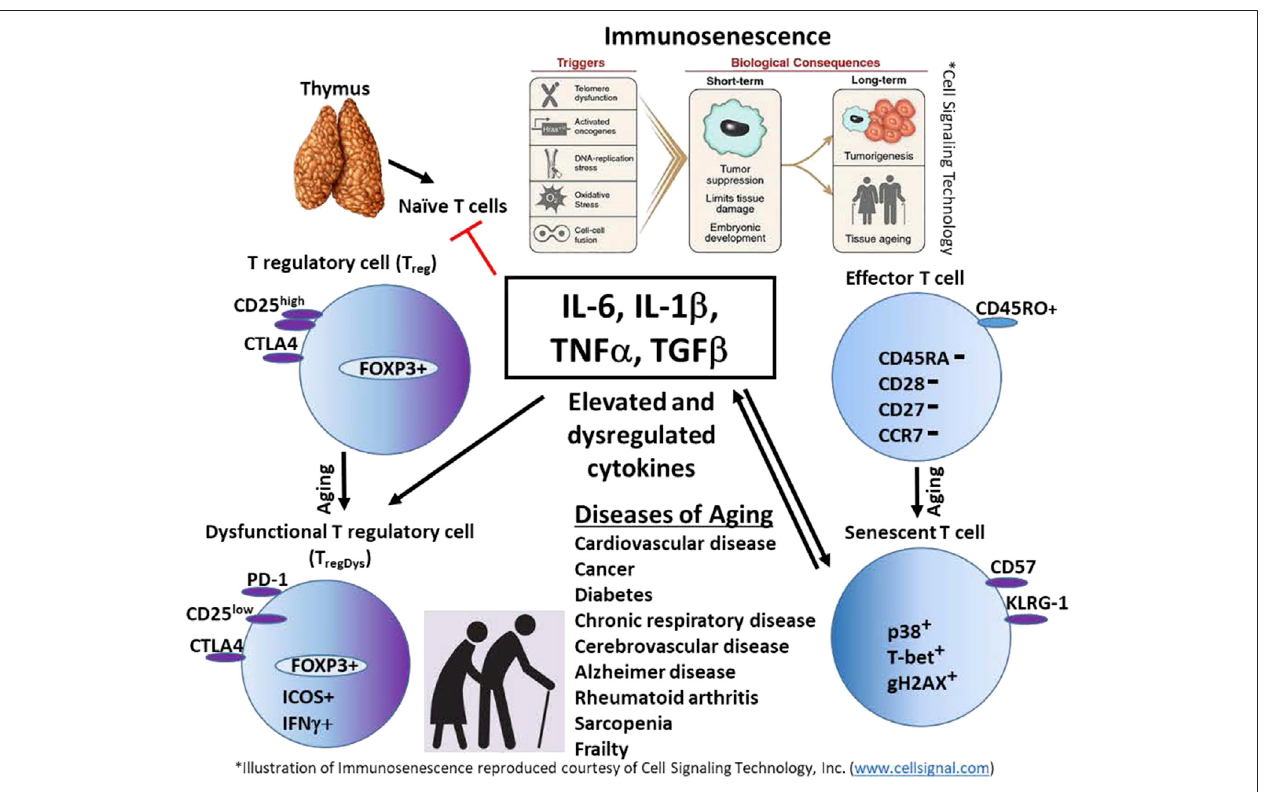
FIGURE1| Model. Persistentelevation ofinnatecytokines such asIL-6, IL-1 β ,TNF α ,and TGF- β ,contribute toimmunosenescence intheelderly. Thesecytokines also promote T cell senescence. Senescent T cells perpetuate in fl ammation by secreting in fl ammatory cytokines. IL-6 also may promote the development of dysfunctional regulatory Tcells (T regDys ),indirectly contributing tochronicin fl ammationinthe elderly. Theresult isagingandimmuneand non-immune diseases